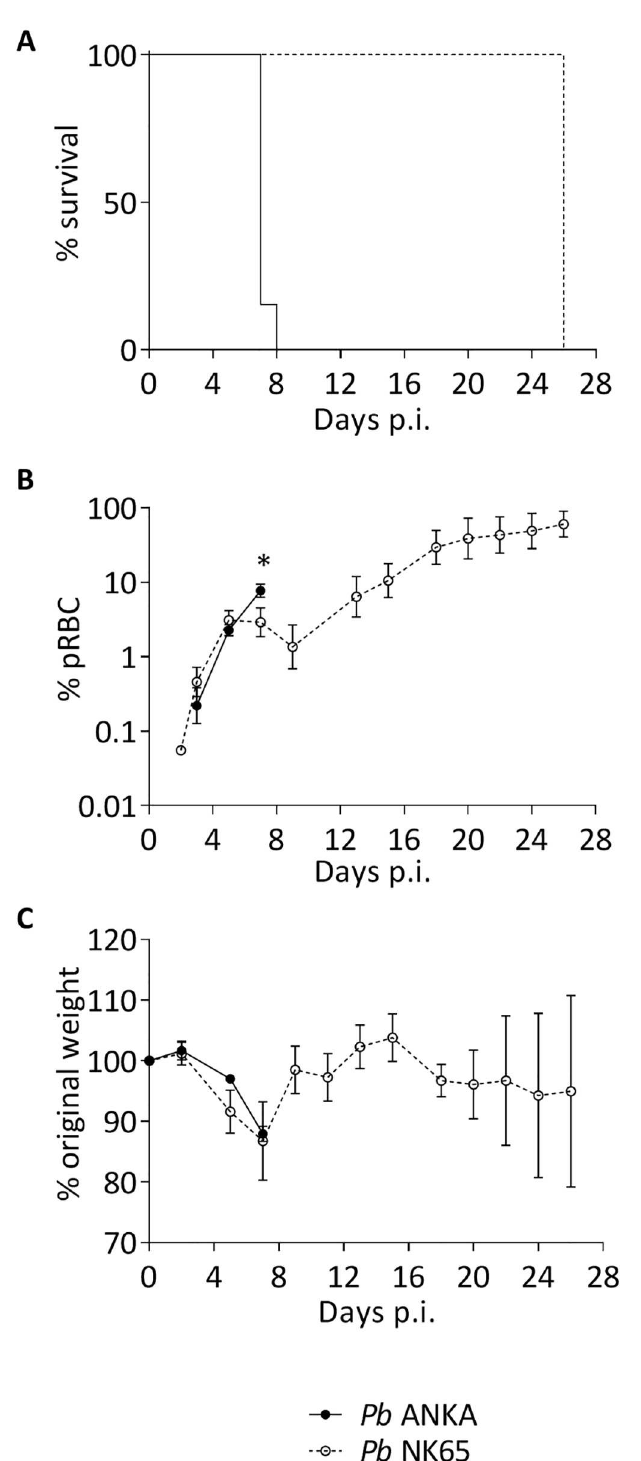
Fig 1. Survival, parasitemia and weight loss during the course of blood stage Pb ANKA and Pb NK65 infection. C57BL/6mice were infected with 1x10 4 Pb ANKA GFP (n = 13) or 1x10 4 Pb NK65 GFP (n = 12) pRBCs. (A) Survival was monitored daily duringthe windowperiod (days 6–12 p.i.) for ECM, and (B) peripheral parasitemia ± SEM and (C) weight loss ± SD were monitoredevery other day duringthe course of